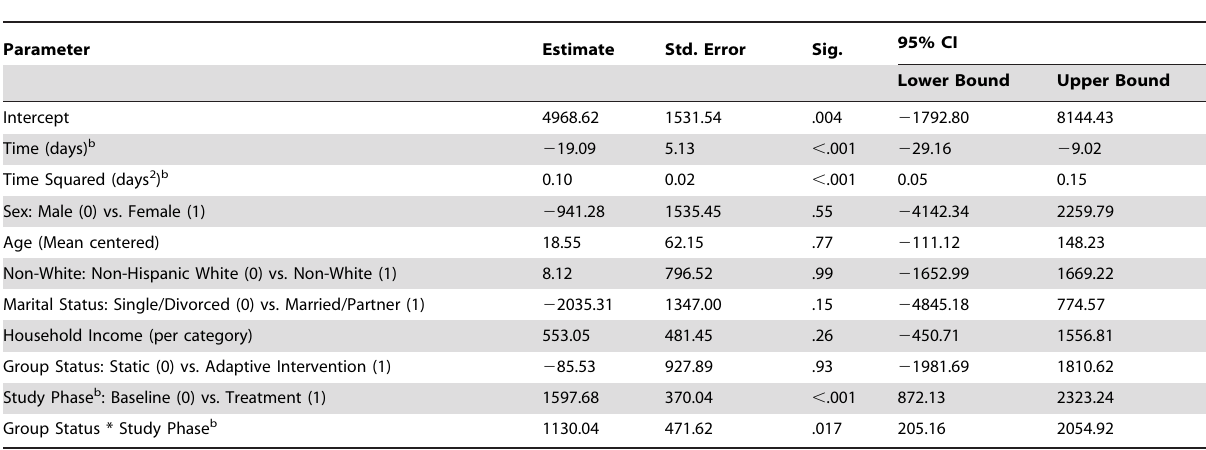
Table 2. Mixed-effects repeated-measures model parameter estimates for steps/day. a